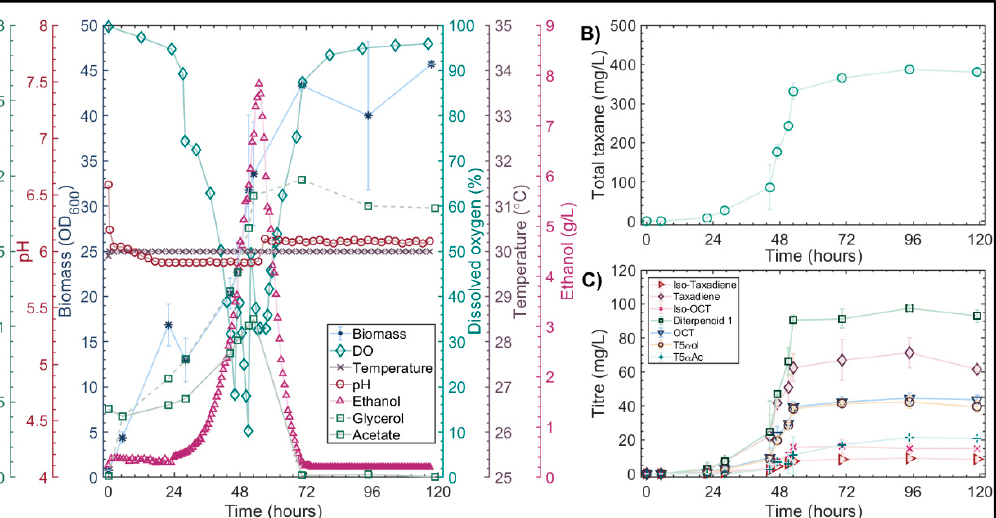
Figure 6. Optimization of taxane production using statistical modeling . The prediction profiler in JMP Pro 15 was used to determine the optimal factor combination according to the statistical model.